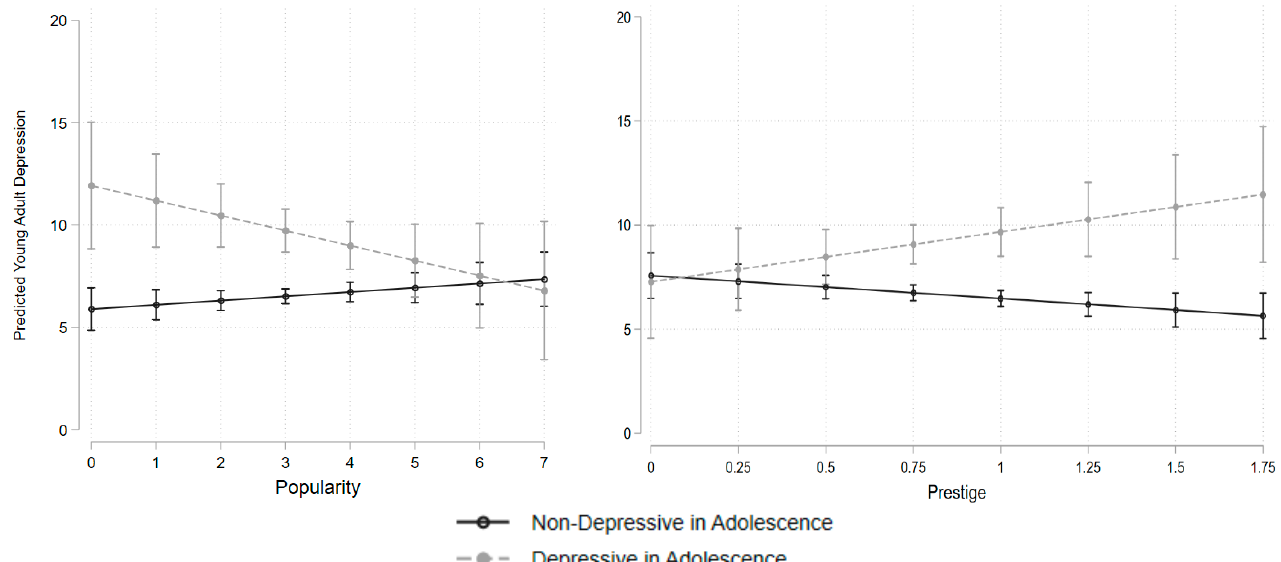
Figure 1. Predicted probability of young adulthood depressive symptoms on adolescent popularity ( A ) and prestige ( B ) by adolescent high school depressive symptoms a .